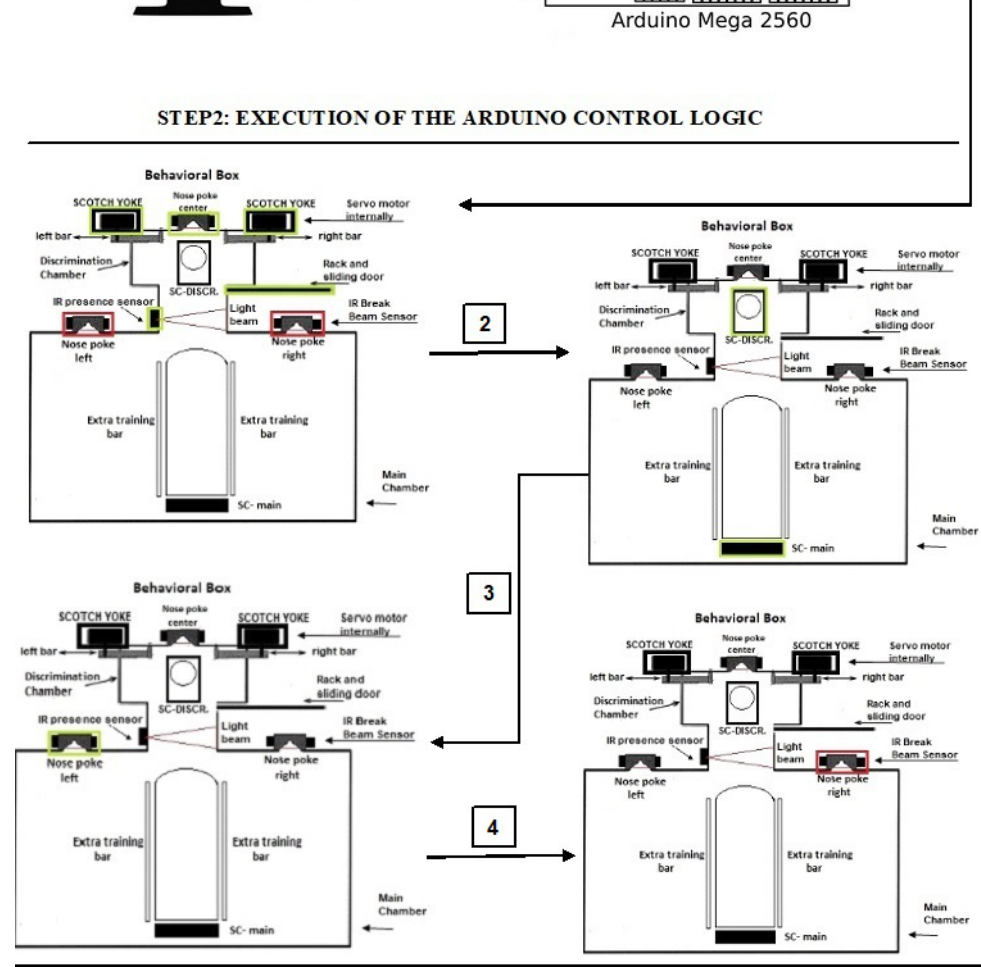
Figure 3. Working logic of the behavioral